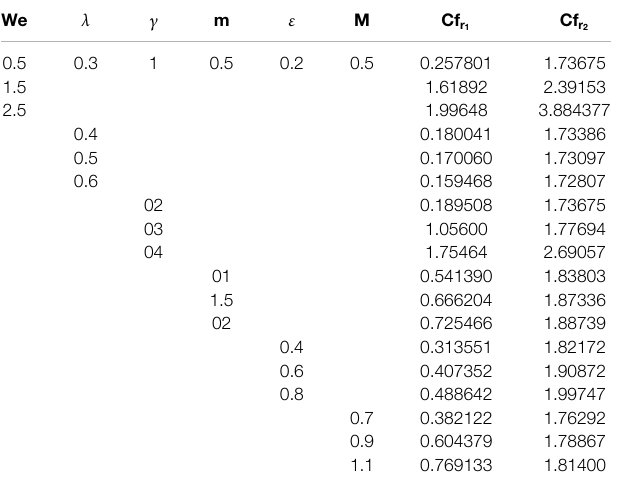
TABLE 2 | Effects of parameters We , λ , c , m , ε , and M on skin friction coef fi cients Cf